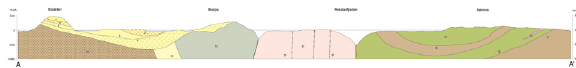
Figure 4: Example of the 3D modelling of the geological structures in 3D MOVE. This shows the Lærdal-Gjende- Figure 7: 50K from Florø area on west coast of Norway. Hardanger Shear Zone (LGHSZ), which for the first time is mapped in 3D over a strike length of over 500km and a dip length of 60km down to the MOHO with the help of offshore seismic data.